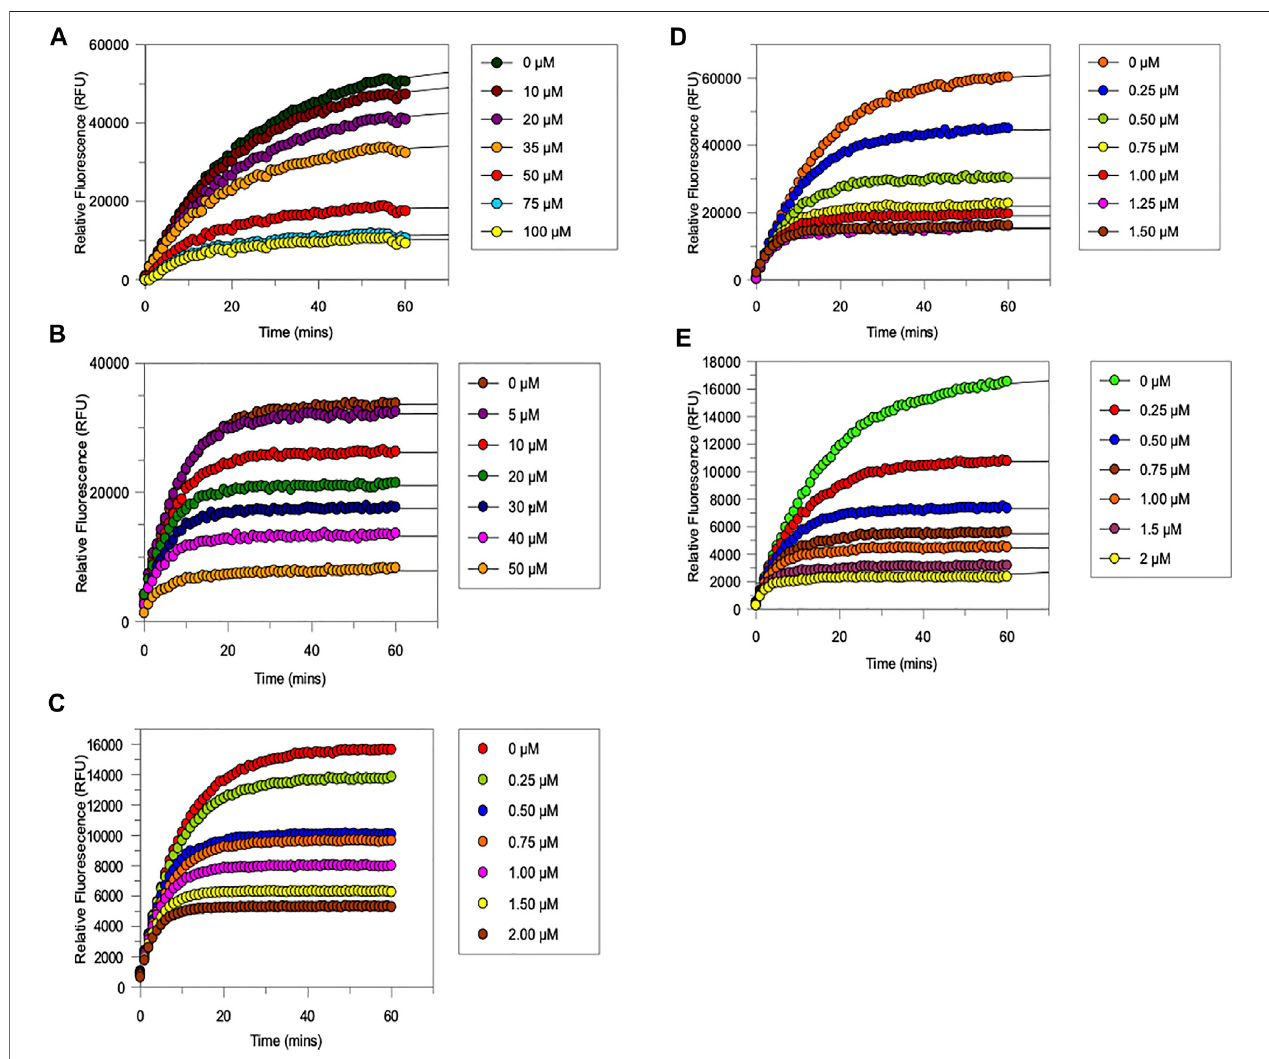
FIGURE 6 | Progress curves for the trypsin-catalysed hydrolysis of Cbz-Gly-Gly-Arg-AMC in the presence of increasing amounts of (A) NAP851, (B) NAP966 (C) NAP897, (D) NAP884and (E) NAP858.AllassayswerecarriedoutinPBS,pH7.4,at37 ° C,usinga fi xedamountoftrypsin(0.004